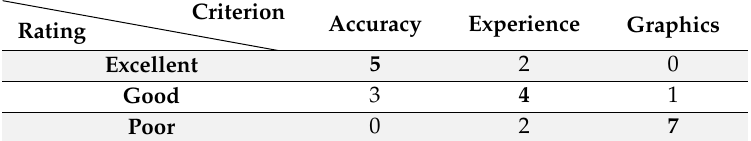
Table 1. Summarized number of users’ rating on CFD visualization (Unit: person / people).